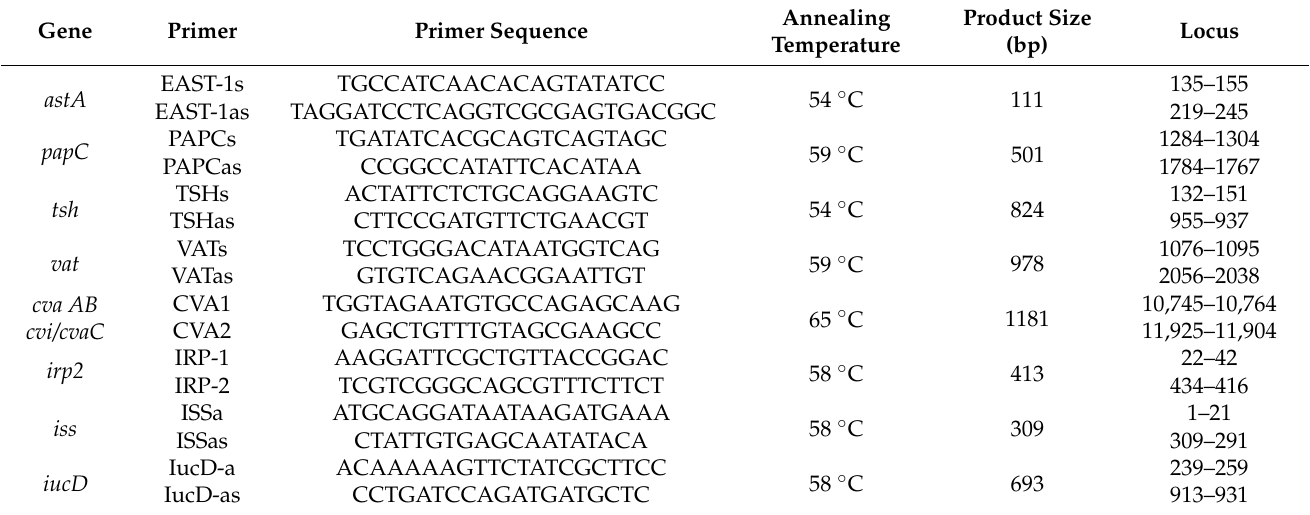
Table 1. Oligonucleotide sequences used in PCR